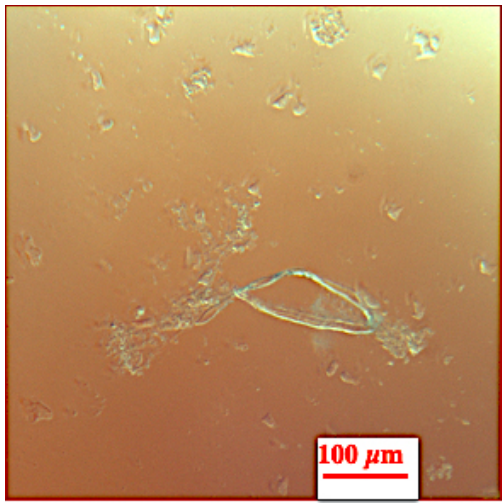
Figure 11. Torn ectoplasmic roots and twigs at the aquarium win- dow on 2 May